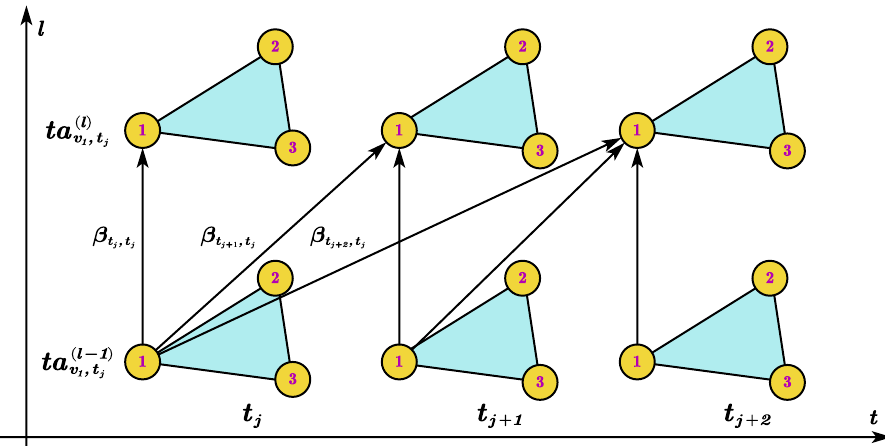
Fig. 5 Principle of masked- temporal attention